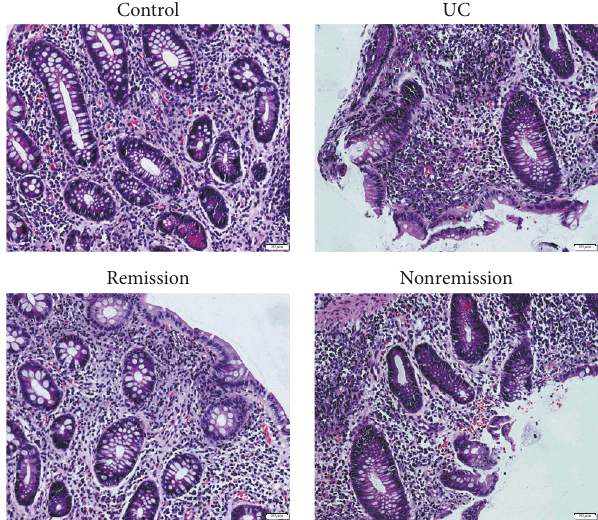
Figure 1: Intestinal morphological changes after ulcerative colitis by HEstaining;UCgroupshowedalotofinflammatorycellinfiltration. In remission, a small number of inflammatory cell infiltrations and bleeding were visible in colonic